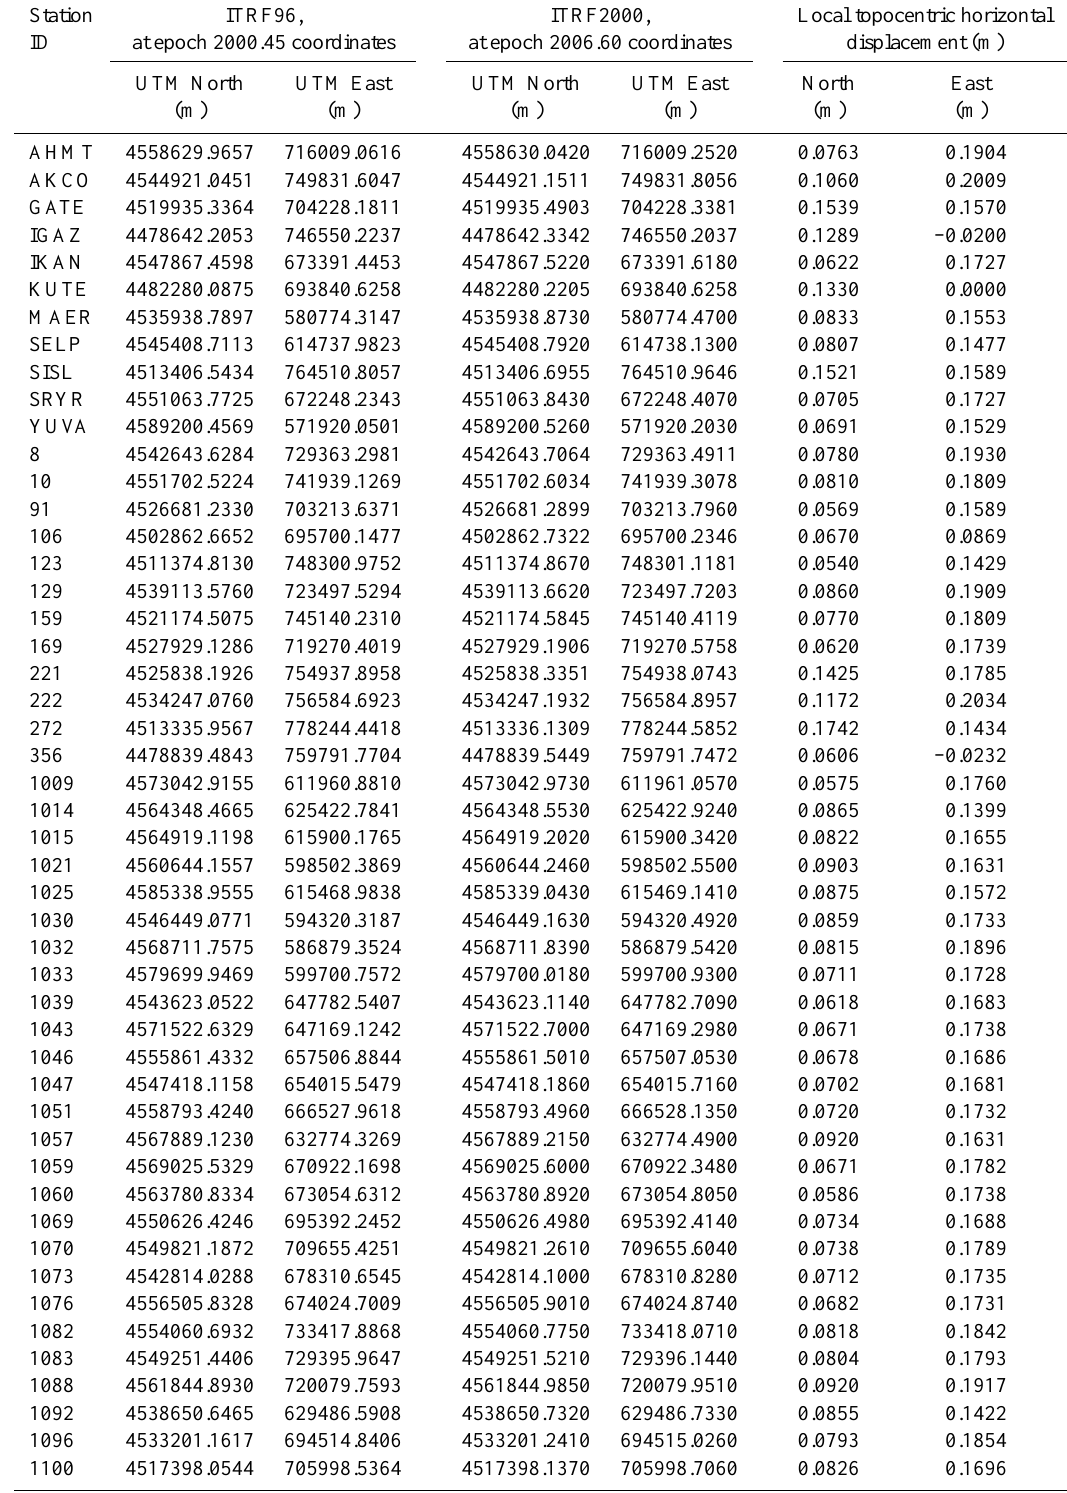
Table 1. Coordinates of stations and displacement